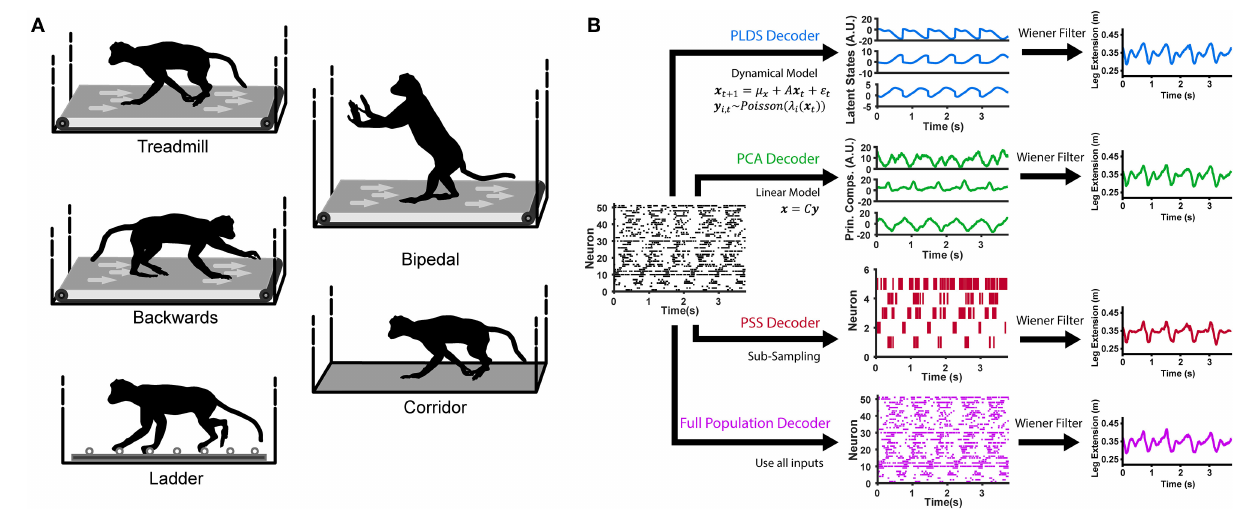
FIGURE 1 | Locomotion behaviors and neural decoding with latent state models. (A) Animals were trained to perform different locomotion tasks in a freely moving, untethered environment. The tasks include basic treadmill walking at various speeds, backwards treadmill walking, bipedal treadmill walking, corridor walking, and ladder walking. (B) Construction of the neural decoders. For decoders implementing dimensionality reduction (PLDS, PCA, PSS), rasters of neural spike counts for each gait cycle (left plot) undergo either an orthogonal linear transformation to extract principle components (center, top), a count-process filter based on a state-space model to extract low-dimensional latent trajectories (center, middle) or a greedy search algorithm to obtain an optimal subsample of neurons (center, bottom). These low-dimensional features are then used as inputs to a Wiener filter for reconstructing the estimate of a desired locomotion variable, such as the leg extension distance (right). The Full Population decoder (bottom path) performs decoding directly on all recorded normalized neural spike counts, binned at 100 ms. For decoding kinematics and gait, the trials of all tasks were combined and shuffled for each